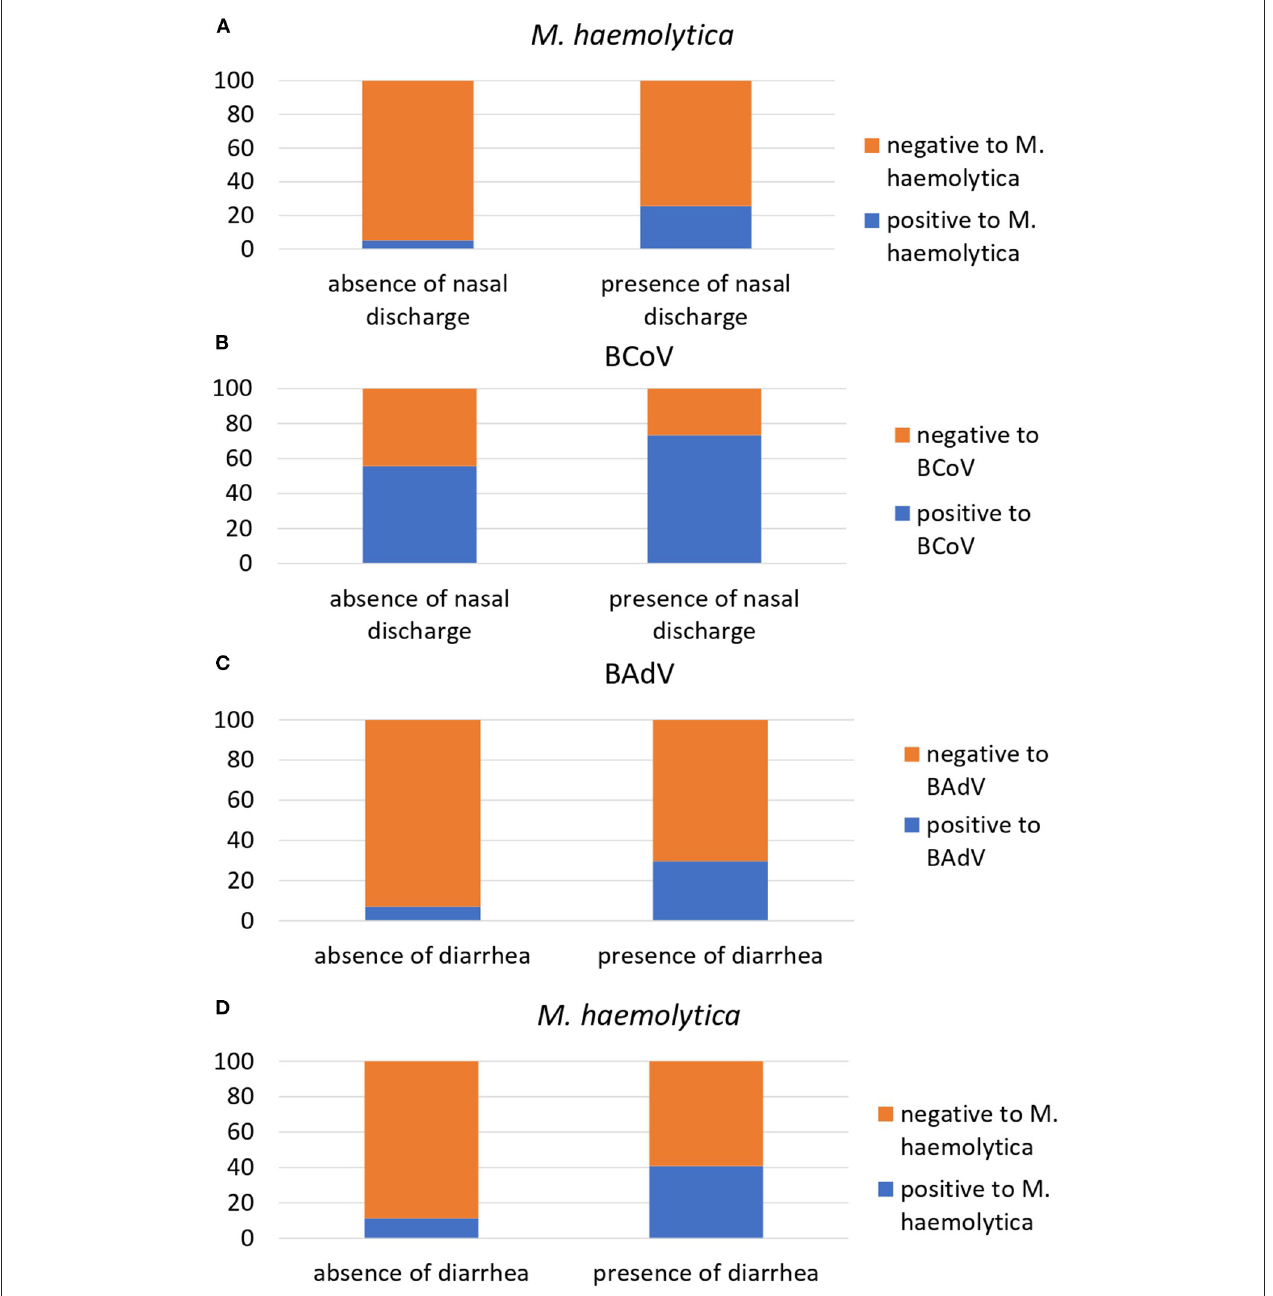
FIGURE 1 | Associations between the presence/absence of nasal discharge and M. haemolytica at T1 (A) , nasal discharge and BCoV at T1 (B) , diarrhea and BAdV at T1 (C) , and between diarrhea and M. haemolytica at T1 (D) in 169 beef steers transported from France to Italy. Each table reports the relative prevalence of the pathogens in animals with or without clinical